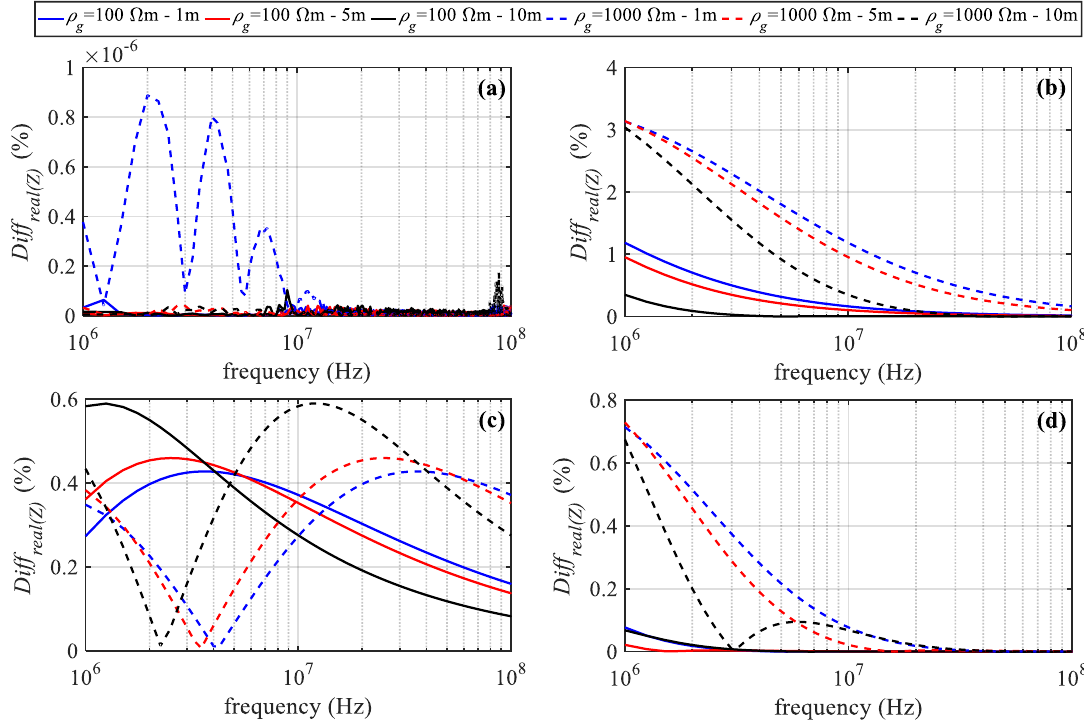
Figure 11. Differences in the real part of Z 13 in BB using the closed-form expression of ( a ) Carson, ( b ) Dubanton ( c ) Noda and ( d ) Alvarado-Betancourt.